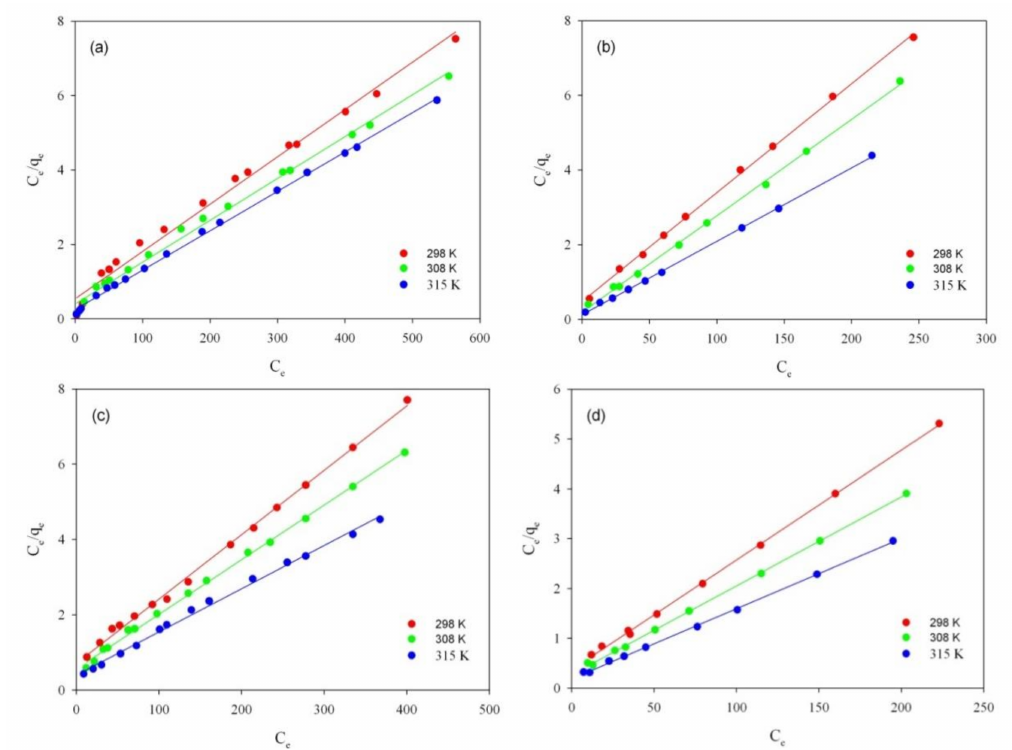
Figure 4. Langmuir isotherm plots for adsorption of RB on ST-A ( a ) and CWZ-22 ( c ), and adsorption of AY17 on ST-A ( b ) and CWZ-22 ( d